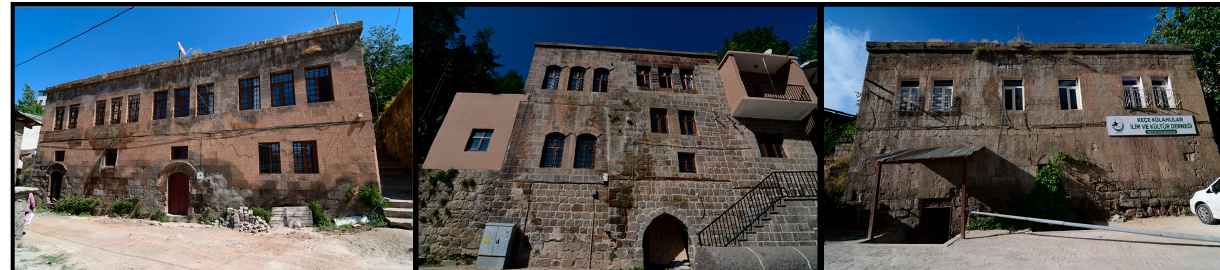
Buildings 2023 , 13 , x FOR PEER REVIEW Figure 17. Some examined masonry structures. Figure 17. Some examined masonry structures.